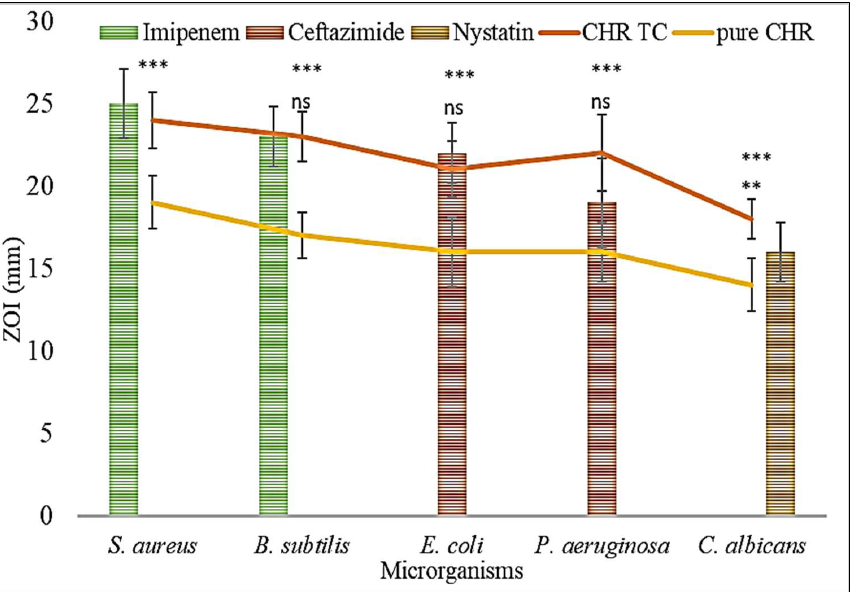
Figure 6. Antimicrobial profile of pure Chrysin (CHR) and Chrysin ternary complex (CHR-TC), and standard compound (Imipenem, Ceftazimide, and Nystatin). The study was performed three times, and the results were shown as mean ± SD. *** highly significant to pure Chrysin, ** significant to pure Chrysin.